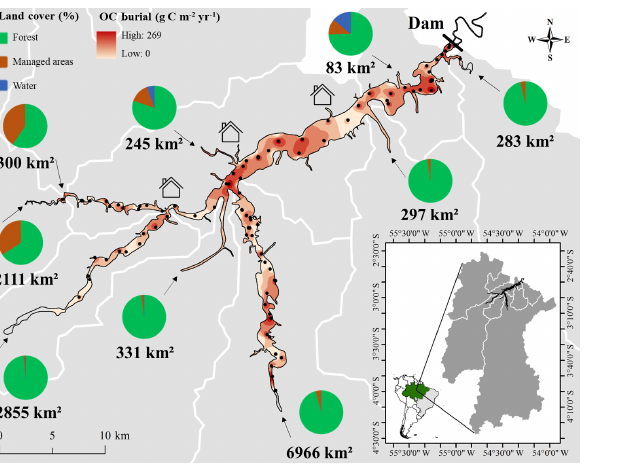
Figure 1. Organic carbon burial rate (OC burial; gCm − 2 yr − 1 ) of the Curuá Una reservoir. The circles show the land cover of each sub-catchment, delineated by white lines. The numbers near the cir- cles show the area (in km 2 ) for each sub-catchment. The black dots represent the sediment sampling sites to estimate OC burial rates. The arrows represent the main river inflows. The houses represent settlements at the reservoir. The bottom-right map shows the loca- tion of the reservoir in Brazil (the green area is the Brazilian Ama- zon region) and the total extension of each